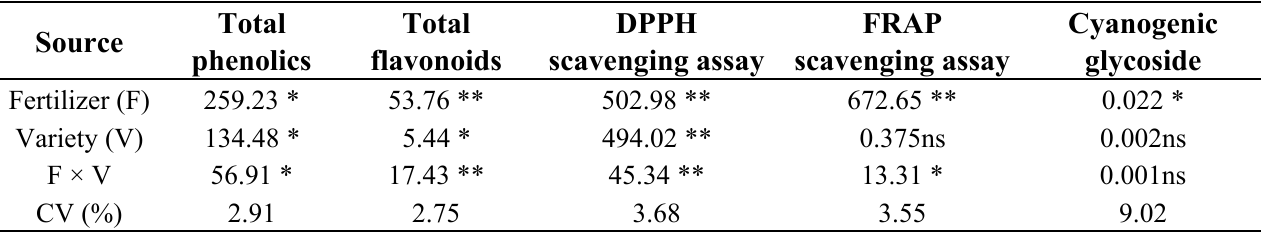
Table 1. ANOVA of Means Square [MS(Pr > F)] for phytochemical compound in tuber.